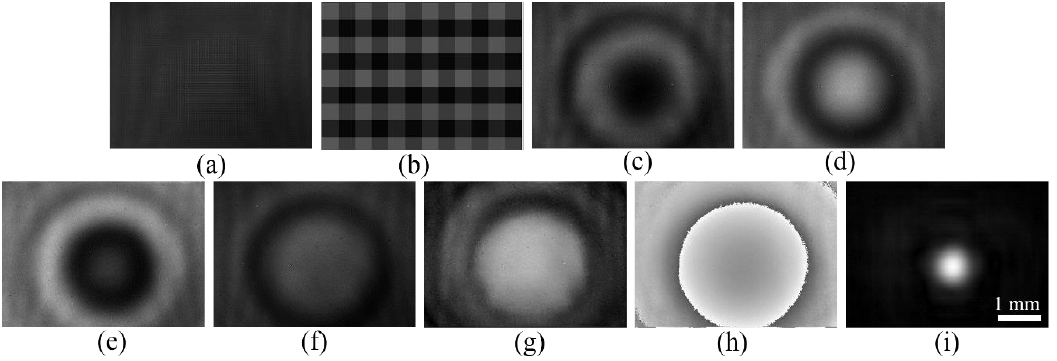
Figure 9. Experimental results. ( a ) Recorded hologram; ( b ) magnified image of a part of ( a ) four phase-shifted holograms, which are generated from ( a ), with ( c ) 0, ( d ) π /2, ( e ) π , and ( f ) 3 π /2 phase shifts; ( g ) amplitude, and ( h ) phase images on the image sensor plane, which are extracted by phase-shifting interferometry; ( i ) reconstructed image of a 1 mm aperture object illuminated by incoherent light.